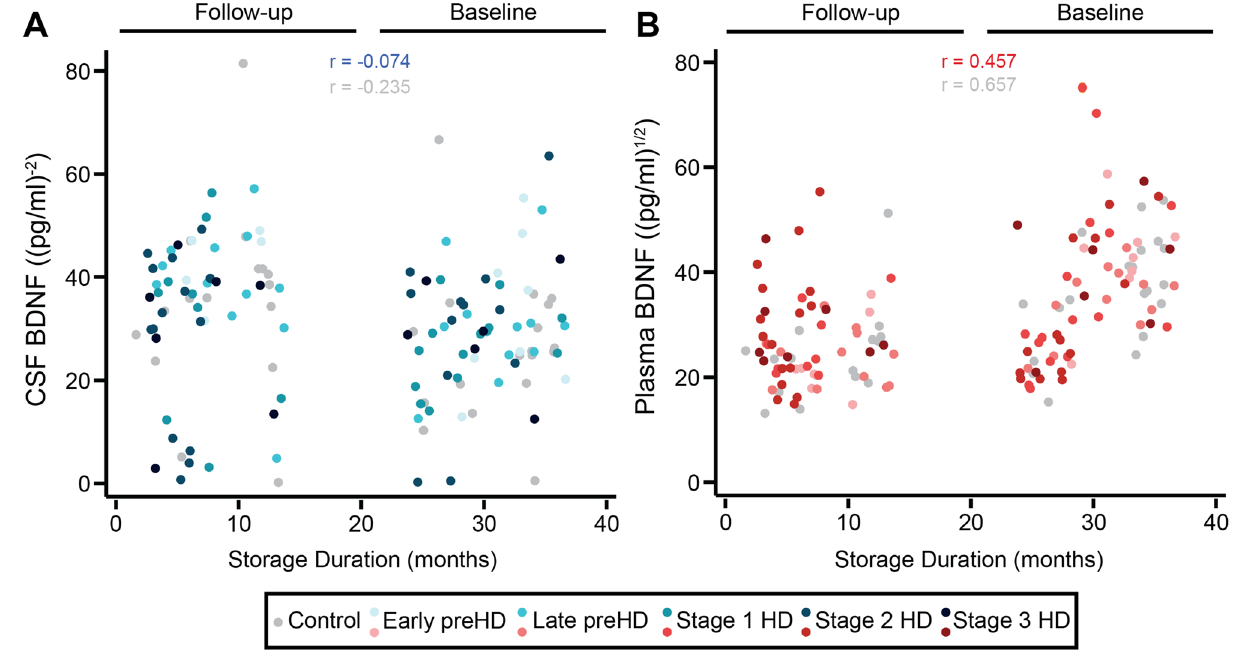
Figure 1. Association between biofluid storage duration and BDNF concentrations. Correlation between the storage duration in months and CSF BDNF ( A ) and plasma BDNF ( B ). CSF BDNF values were inverse square transformed and plasma BDNF were square root transformed. CSF, cerebrospinal fluid; HD, manifest HD mutation carriers; PreHD, premanifest HD mutation carriers; BDNF, brain-derived neurotrophic